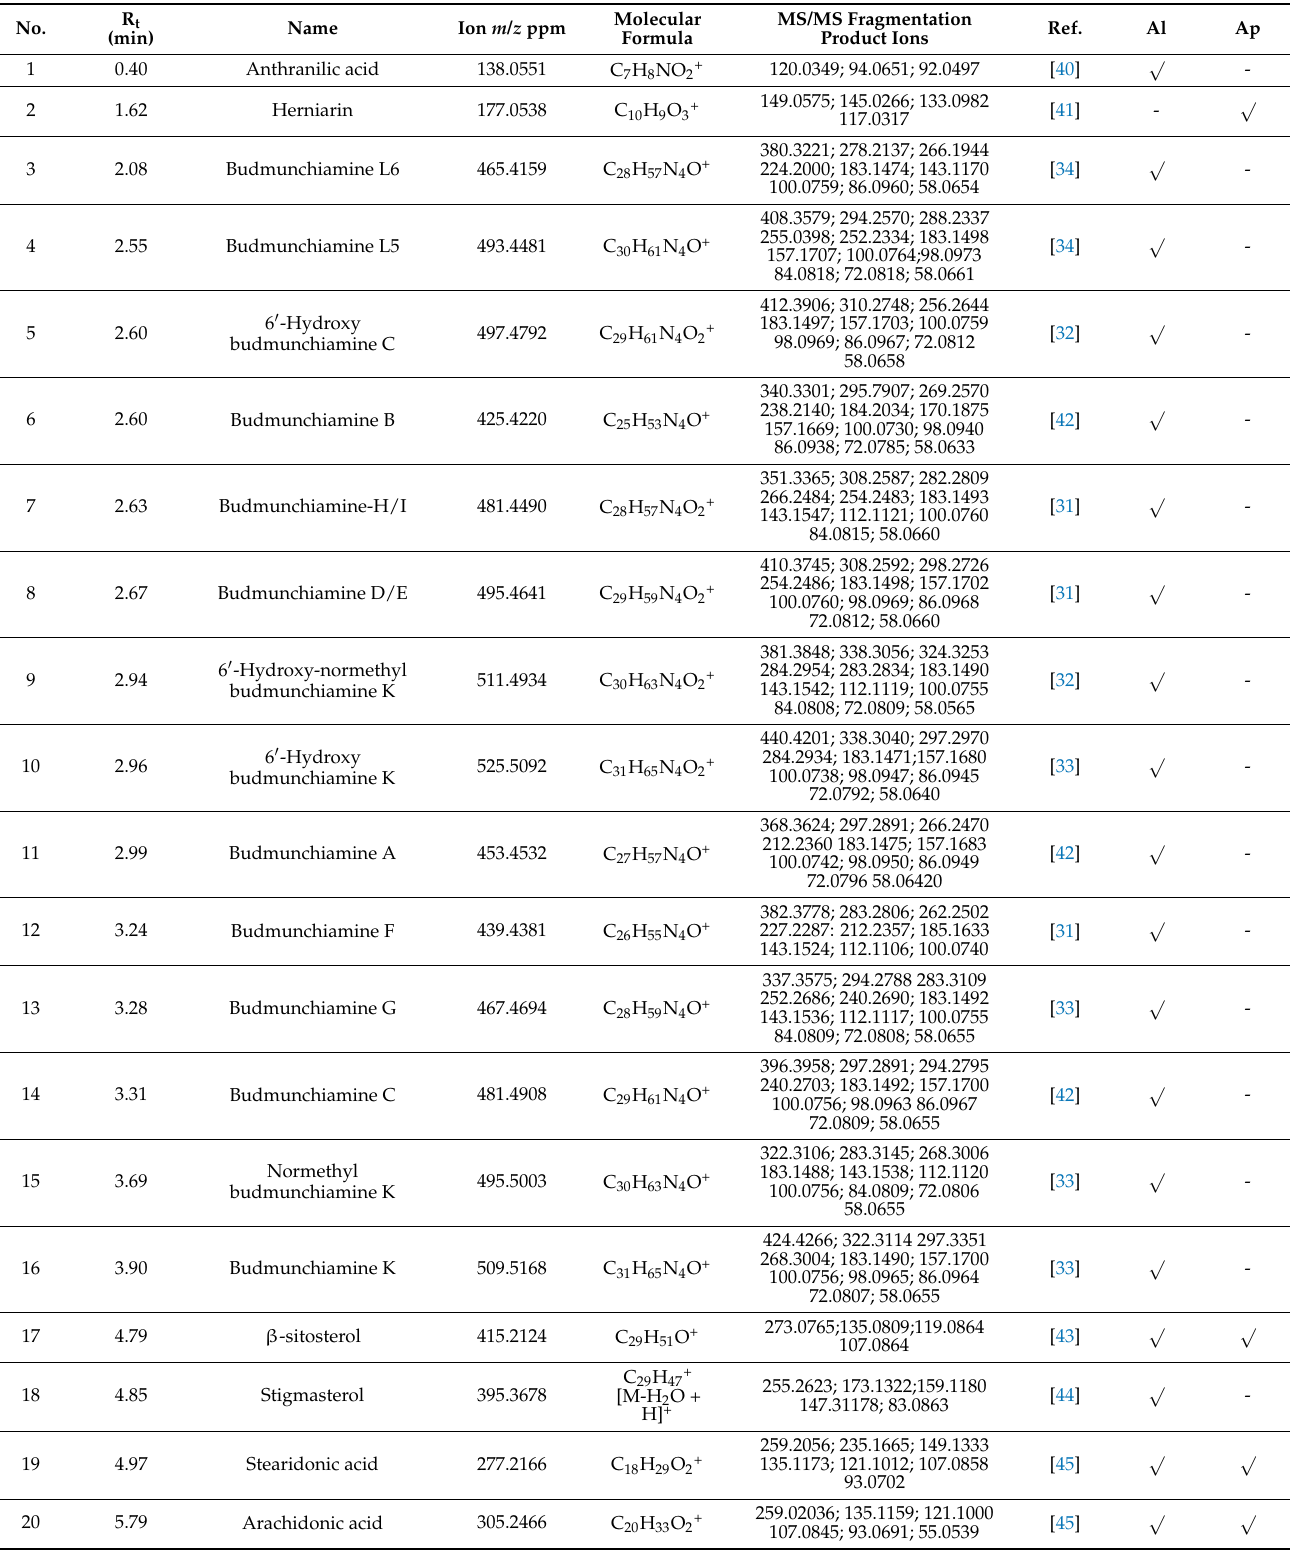
Table 2. Identified metabolites in the positive ion mode of ethanolic extracts of A. lucidior and A. procera leaves using